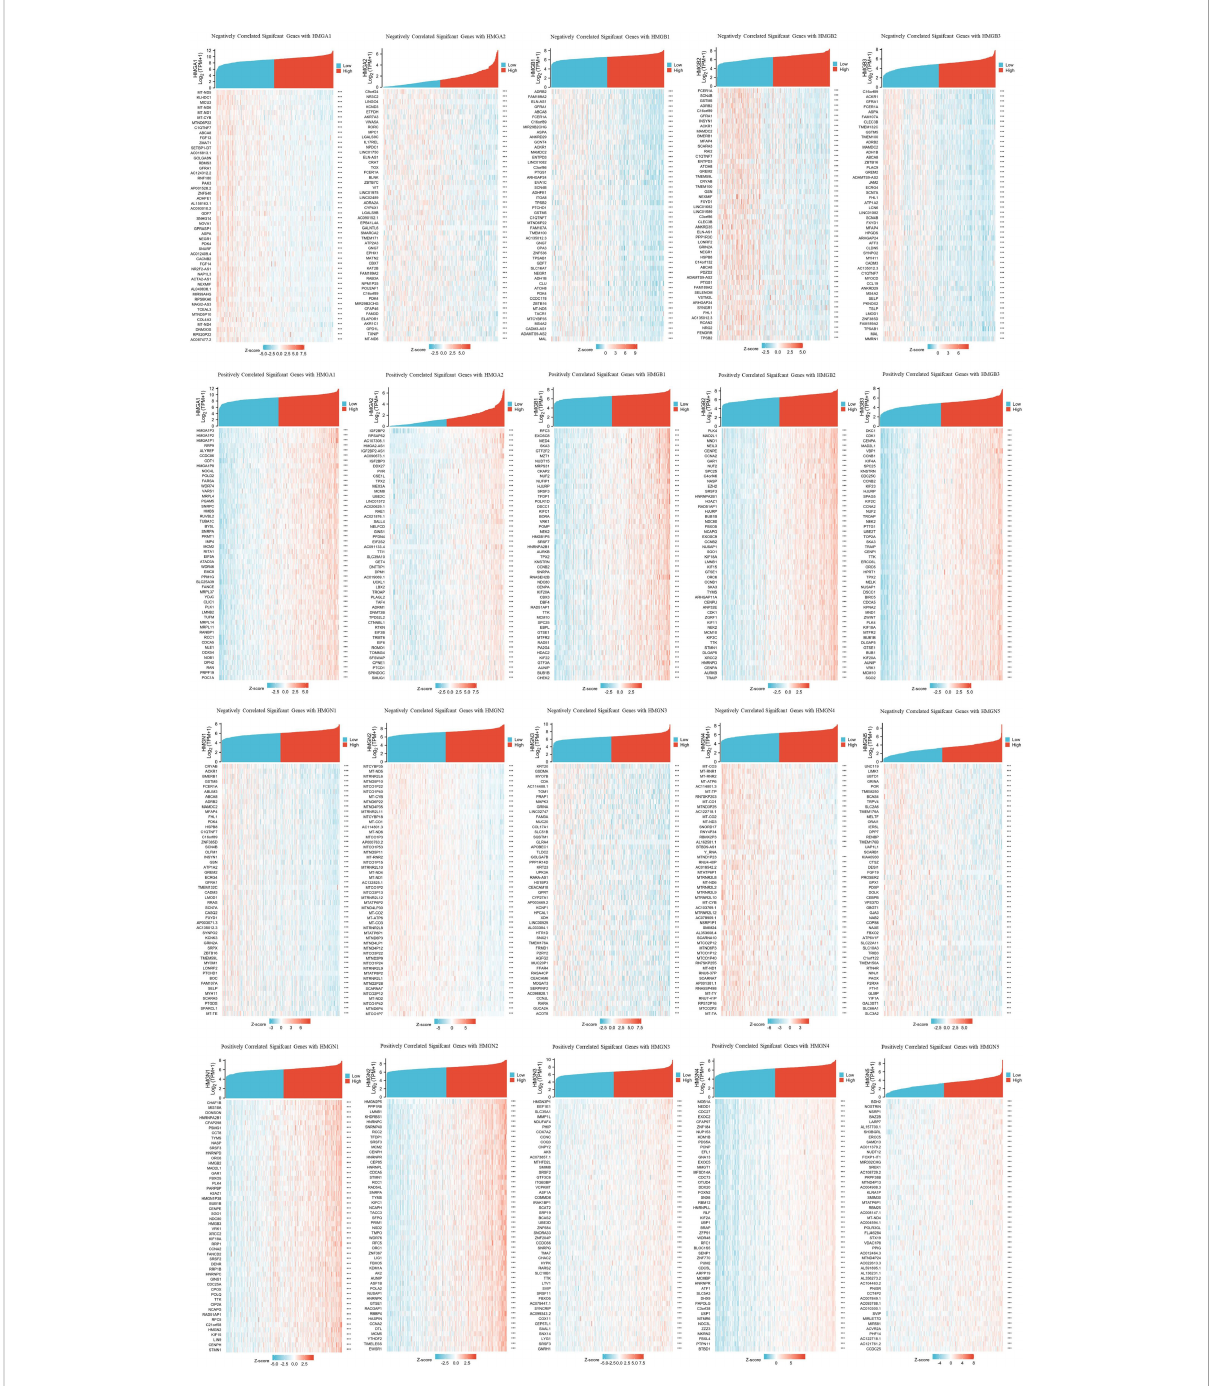
FIGURE 8 Heatmap plot of top 50 associated genes to HMGs (negatively and